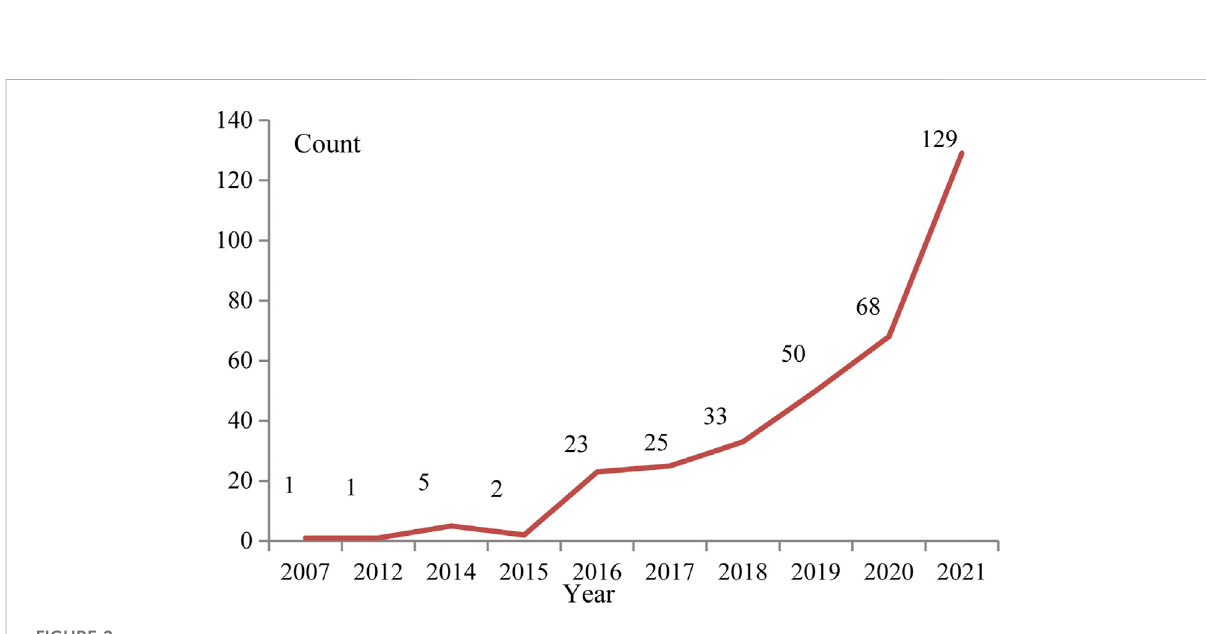
FIGURE 2 Change chart of annual number of issued